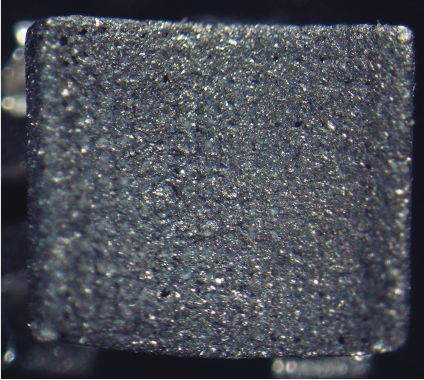
Figure 4: Equilibrium 2 bracket,